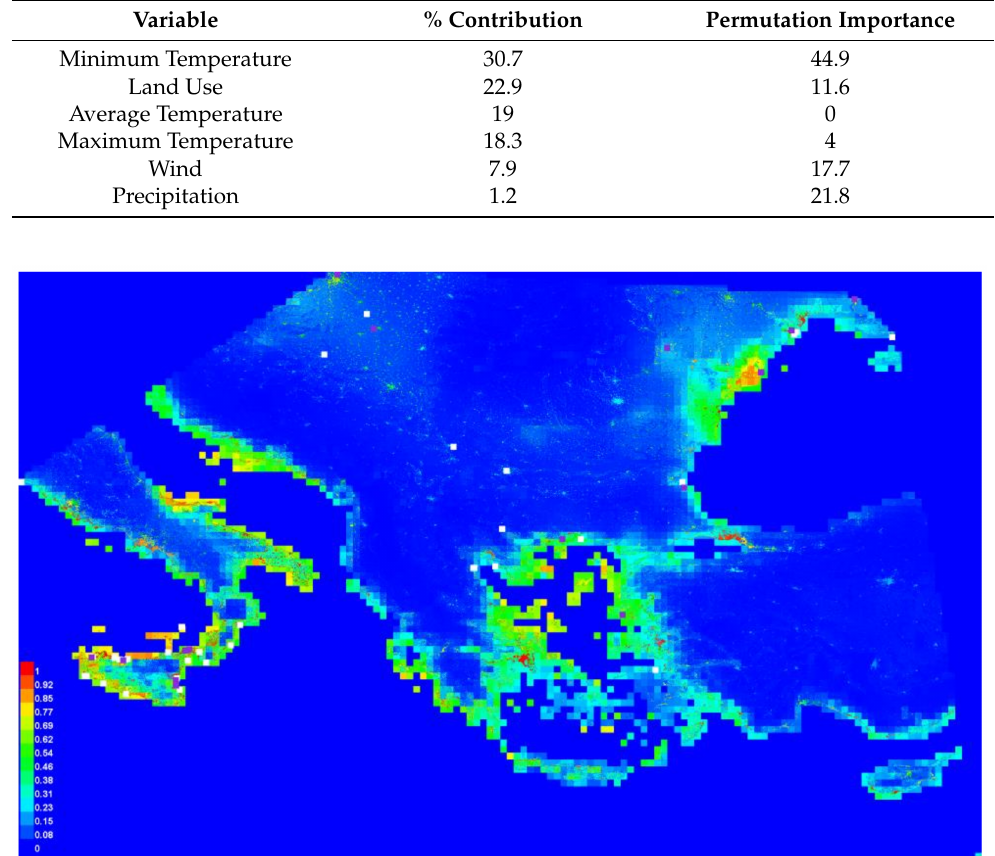
Figure 4. Graphical model map of Anoxia orientalis in Europe. Different colors would indicate the probability of occurrence of the species on the basis of the given ensemble of